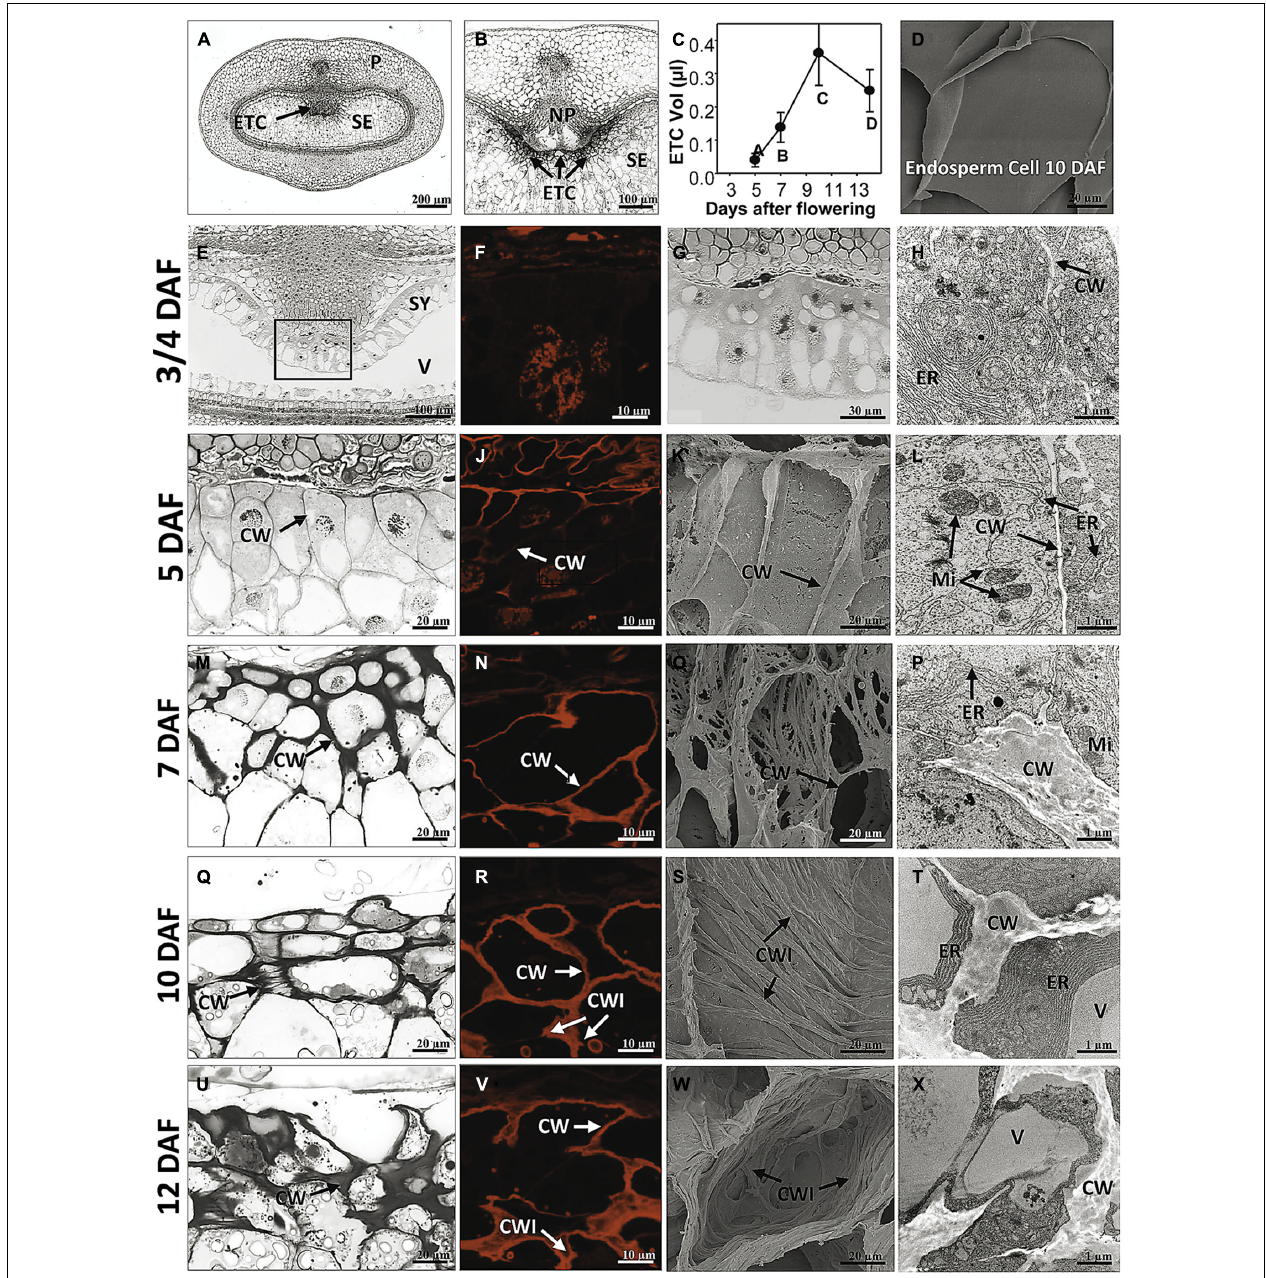
FIGURE 1 | Morphological and ultrastructural analysis of barley ETC development. Light microscopy (E,G,I,M,Q,U) , DIC fluorescence microscopy (F,J,N,R,V) , scanning electron (K,O,S,W) and transmission electron microscopy (H,L,P,T,X) images show ETC differentiation from cellularization (3/4 DAF) until the establishment of transfer cell structure (12 DAF). (A) Median cross section of a barley grain at 7 DAF depicts grain tissues and (B) magnification shows the transfer region of barley grains. (C) Volume of ETCs from 5 to 14 DAF, (D) scanning electron picture of an endosperm cell at 10 DAF. At 3/4 DAF, cellularization in the region of the syncytium facing the nucellar projection has just started (E,G) . Cells contain a dense cytoplasm, rich in organelles of the endomembrane secretory system, and segments of cell walls are apparent but do not border complete cells (arrow, H ). At 5 DAF, cellularization of the ETC region is completed; up to three rows of cells facing the NP are apparently different from the other cells of the